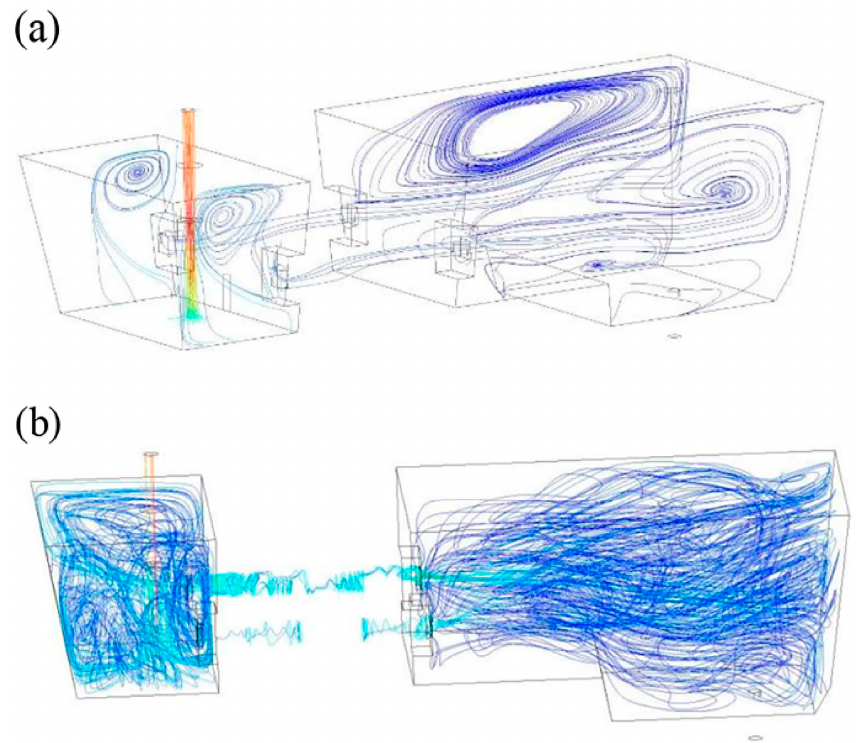
Figure 5. Molten steel path line in tundish without ( a ) and with ( b ) induction heating [26] .